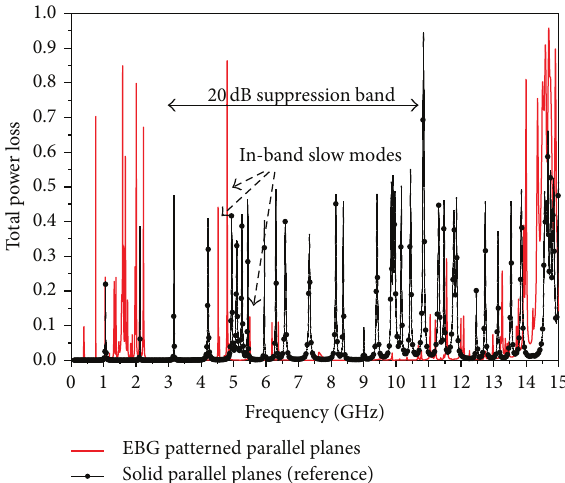
Figure6:Totalpowerloss(1 −|𝑆 11 | 2 −|𝑆 21 | 2 )versusfrequencyfortwo setups: (i) the EBG-patterned parallel planes as shown in Figure 4 and (ii) the corresponding solid parallel planes as a reference.